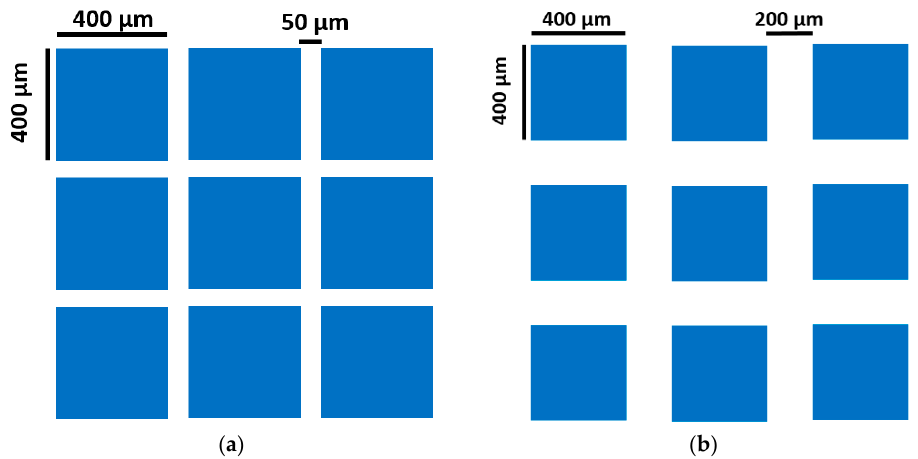
Figure 1. Outline of the laser structuring performed on ( a ) ST2 and ( b ) ST3. Basins created by laser ablation are indicated by color. Table 1. Laser parameters for structures on ST2 and ST3.